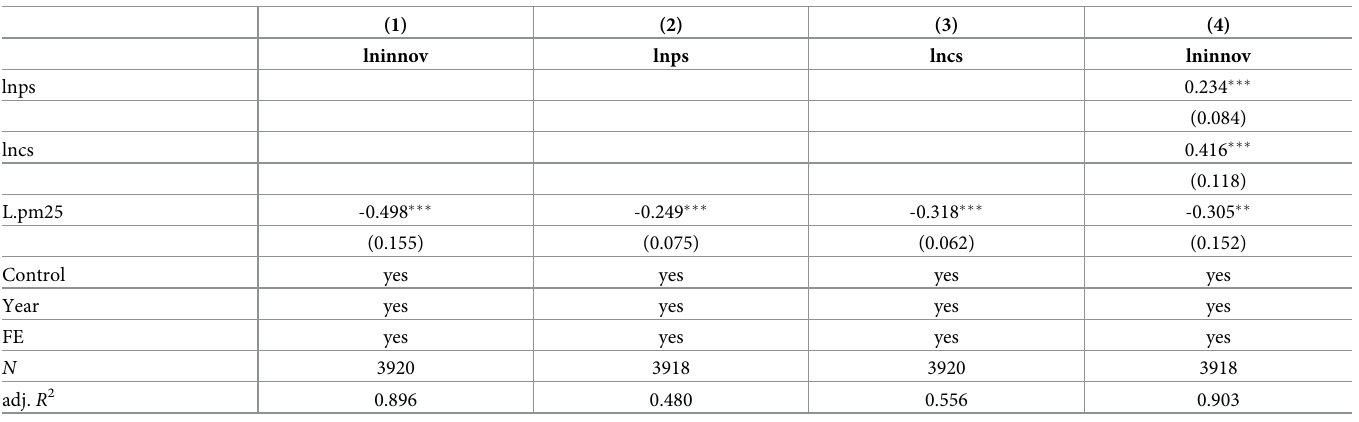
Table 16. Producer services and consumer